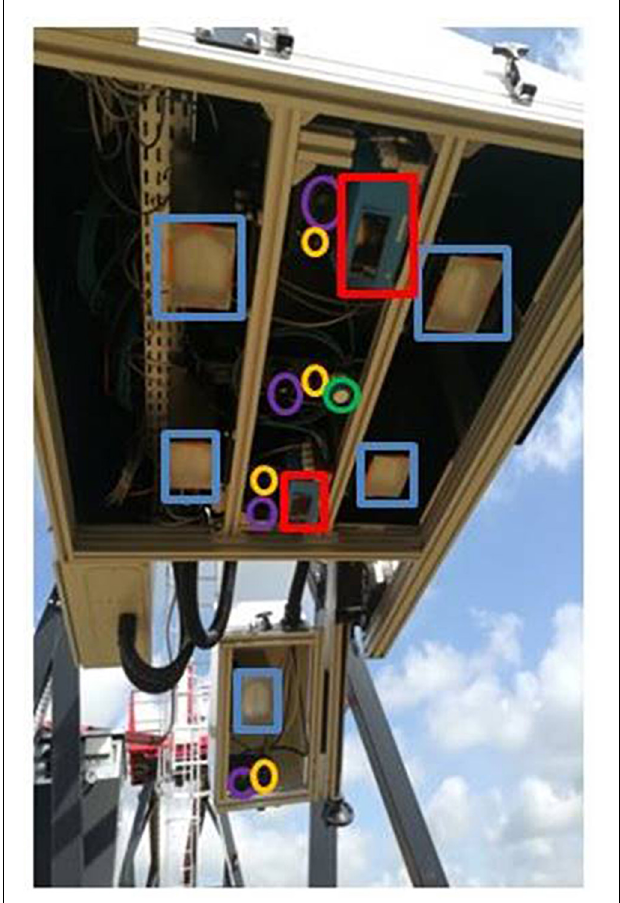
FIGURE 3 | Bay carrying the sensors with 2 angles of view. The shapes show the 2 LIDARs (in red), the 4 cameras (in purple), the 4 spectroradiometers (in yellow), the flashes (in blue) and the telemeters (in